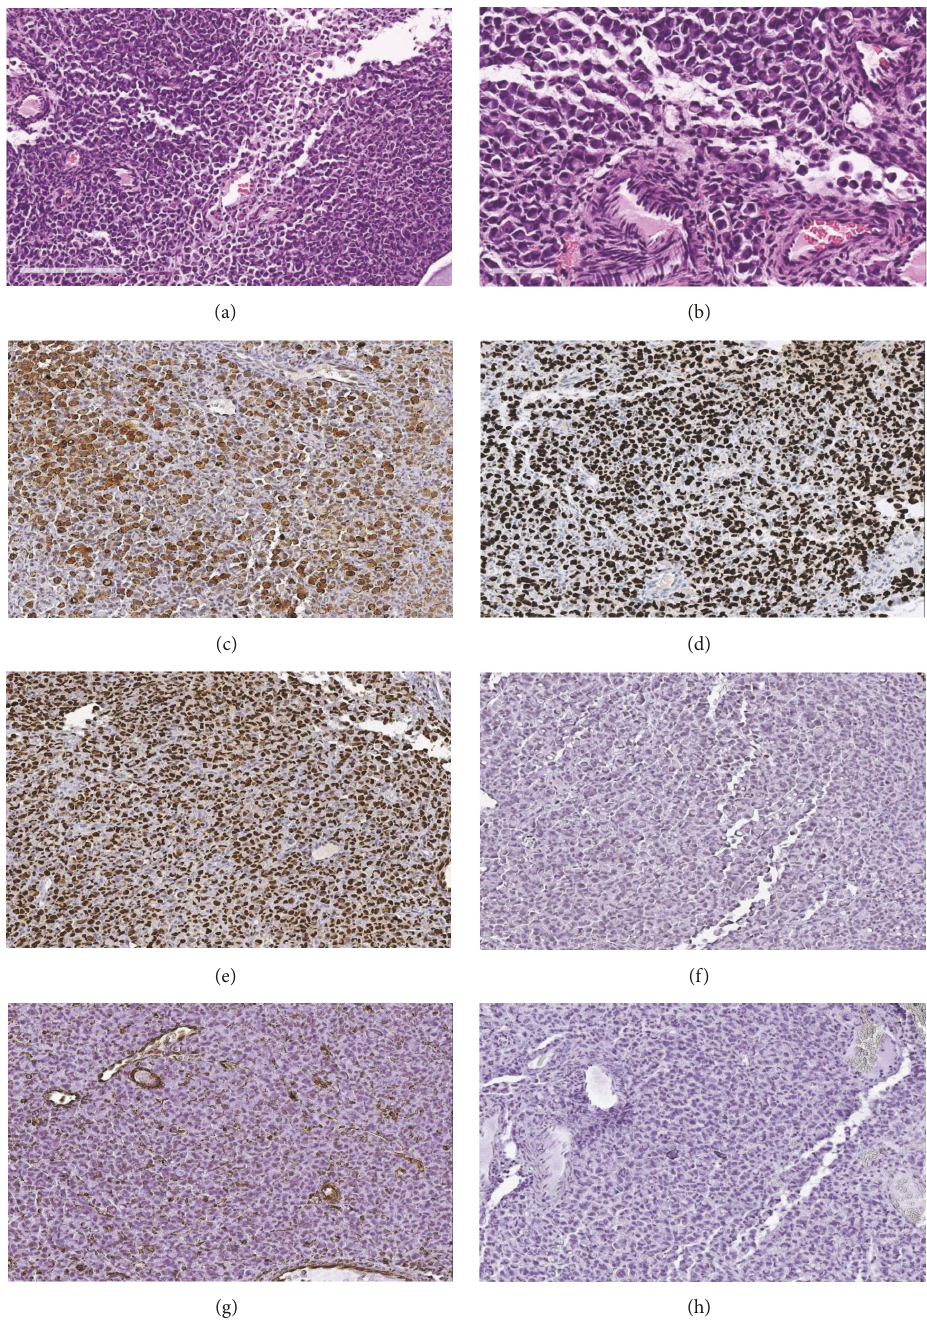
Figure 1: Pathological microscopic examination . (a-b) 20X-40x. Hematoxylin-Eosin shows replacement of endometrial stroma by tumor cells, solid architecture with infiltrative growth as single cells was shown, and discohesive cells are observed with plasmacytoid and “signet ring” morphology with scant cytoplasm and rejected hyperchromatic nucleus. (c) 20x. Mammaglobin immunohistochemistry staining shows positivity in malignant cells. (d) GATA3 immunohistochemistry staining shows strong nuclear positivity in malignant cells. (e) 20x estrogen receptor immunohistochemistry staining shows strong nuclear positivity. (f) 20x PAX-8 immunohistochemistry was negative. (g) 20x vimentin immunohistochemistry staining shows positivity just in blood vessels but it is negative in malignant cells. (h) CDX-2 immunohistochemistry staining shows negativity discarding an origin in digestive